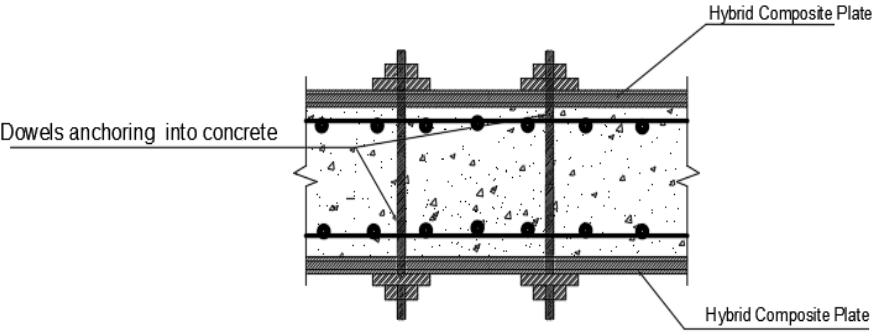
Figure 13. Hybrid composite plate retrofitting process with dowels anchoring into RC specimen [82].